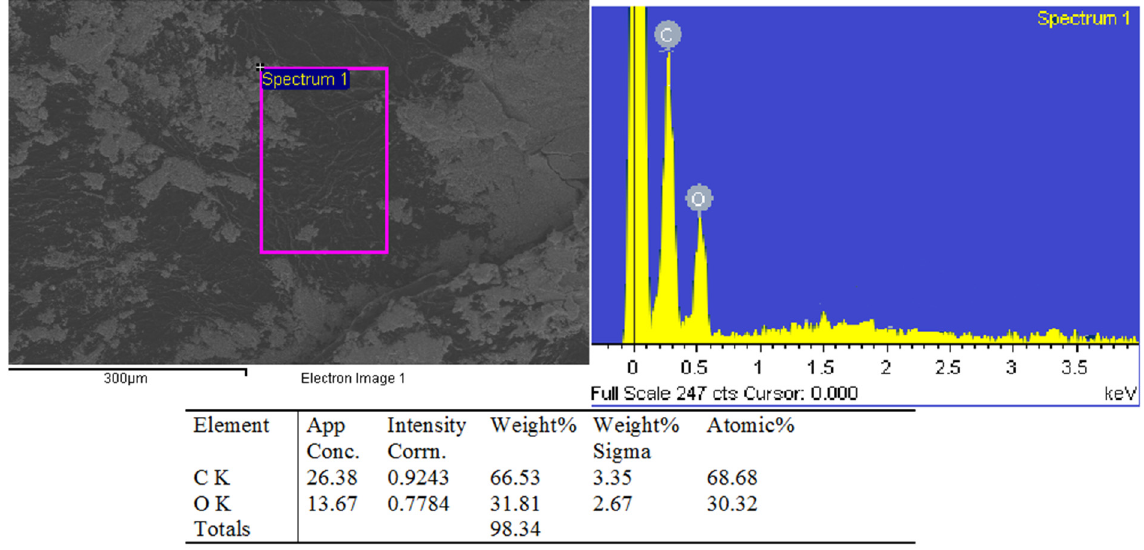
Figure 2. Photomicrograph of a section of the surface of a GO sheet and elemental analysis at this point.